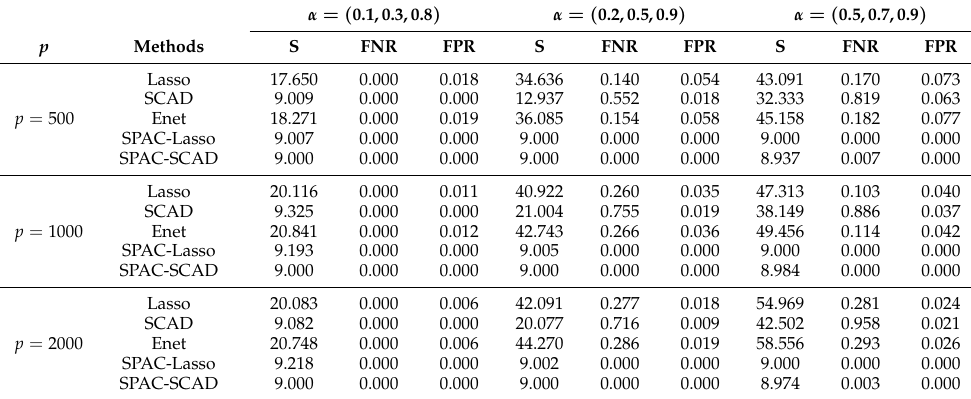
Table 2. Variable selection results for treatment and control groups. α = ( 0.1,0.3,0.8